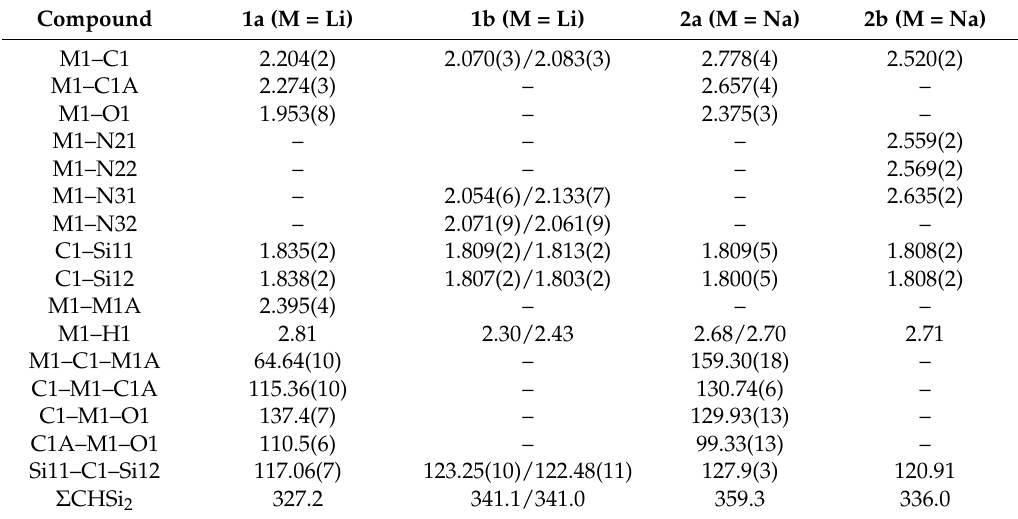
Figure 3. Molecular structure of LiCH(SiMe 3 ) 2 -THF, 1a . Selected hydrogen atoms and disordered units of minor occupancy are omitted for clarity. Symmetry operator A: − x , − y and − z . Table 6. Selected bond lengths (Å) and angles ( ◦ ) of compounds 1a , b and 2a , b .